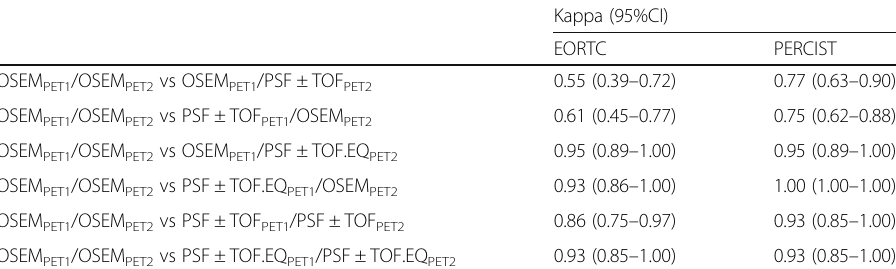
Kappa (95%CI) EORTC PERCIST